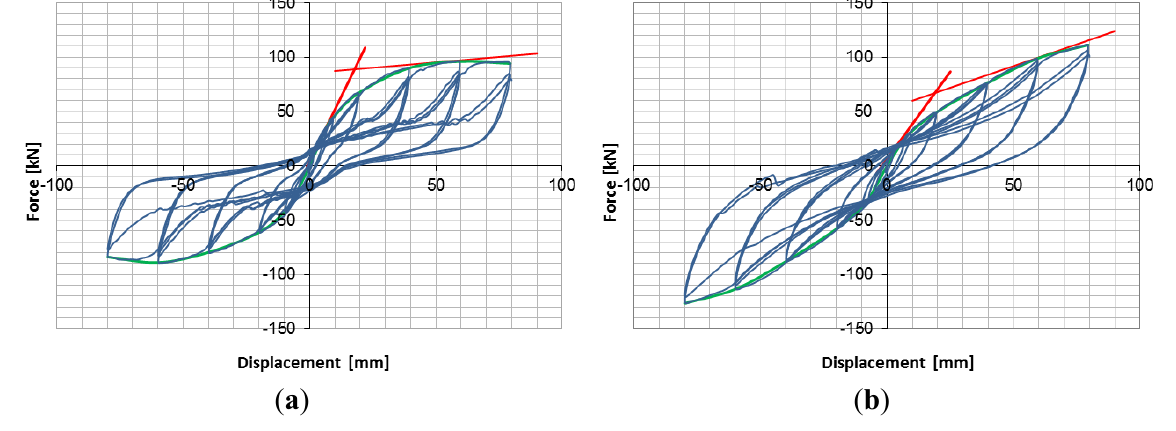
Figure 15. Hysteresis cycle and definition of yielding point, according to EN